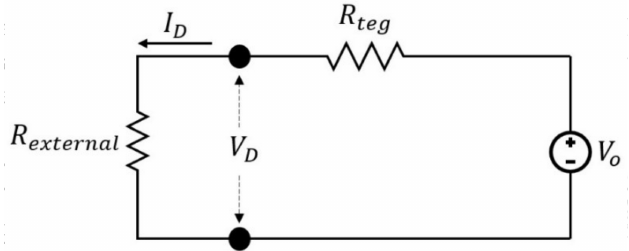
Figure 6. Electrical equivalent